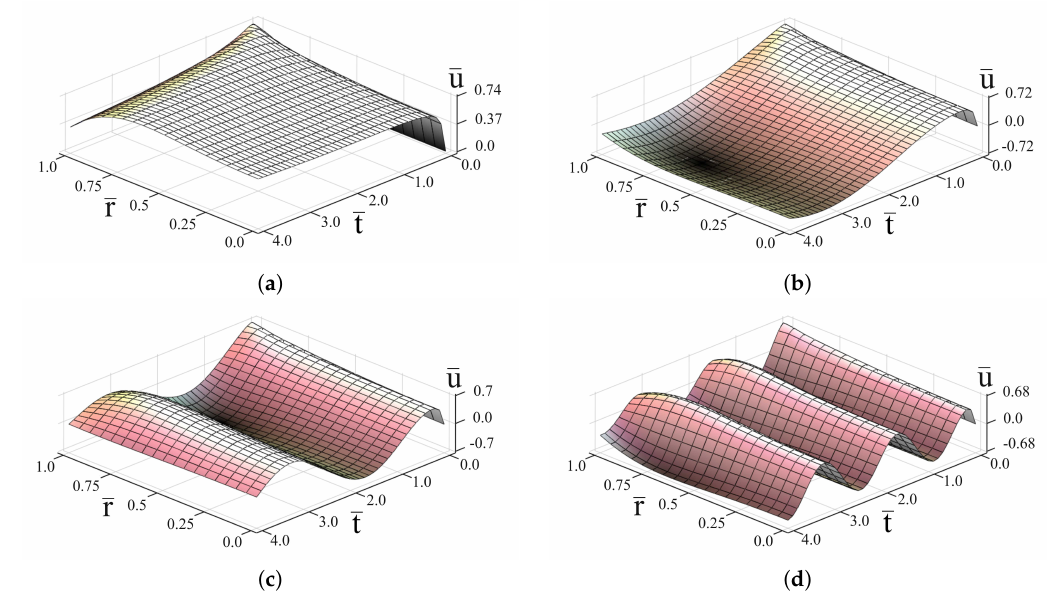
Figure 3. Evolution of the solution for the problems (12)–(15) with increasing the frequency ¯ ω in the sub-diffusive case. The results of computer simulation of the formula (27) for the parameters ¯ b = 1, α = 0.75 and different values of ¯ ω : ¯ ω = 0.0—( a ); ¯ ω = 1.0—( b ); ¯ ω = 2.0—( c ); ¯ ω = 4.0—( d ).